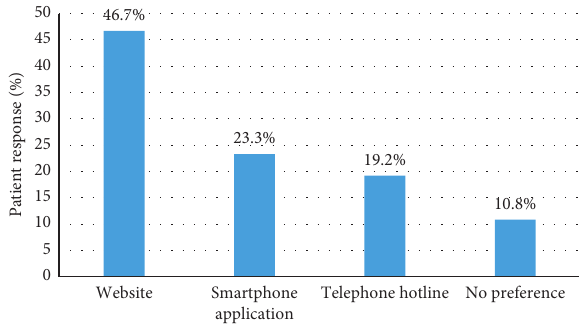
Figure 1: Patient number one ranked preference for modality of wait time notification prior to arrival in ED ( N � 240).